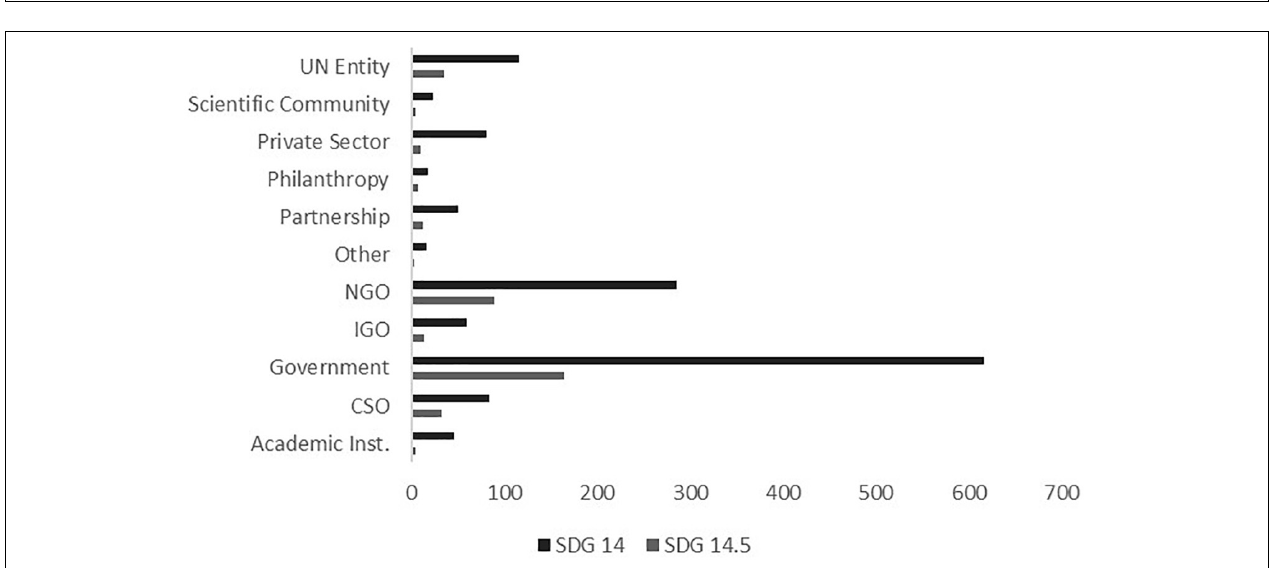
FIGURE 1 | Voluntary ocean commitments. Number of voluntary commitments ( N = 3,795) made with regards to sustainable development goal (SDG) 14 (Life under water) subgoal. Note that an individual commitment could address multiple specific goals. Data collected from https://oceanconference.un.org/commitments/ between June 2017 and September 2017.